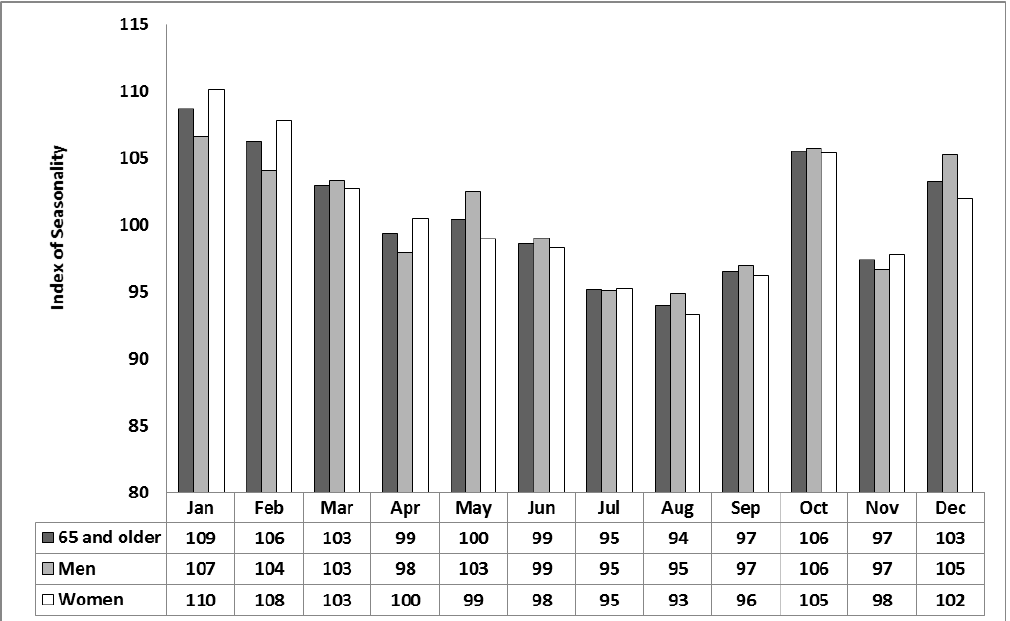
Figure 2. Monthly Index of Seasonality (IS) for Khabarovsk for the period 2000–2012 based on mean daily all-cause mortality for men, women and both men and women 65 years and older.